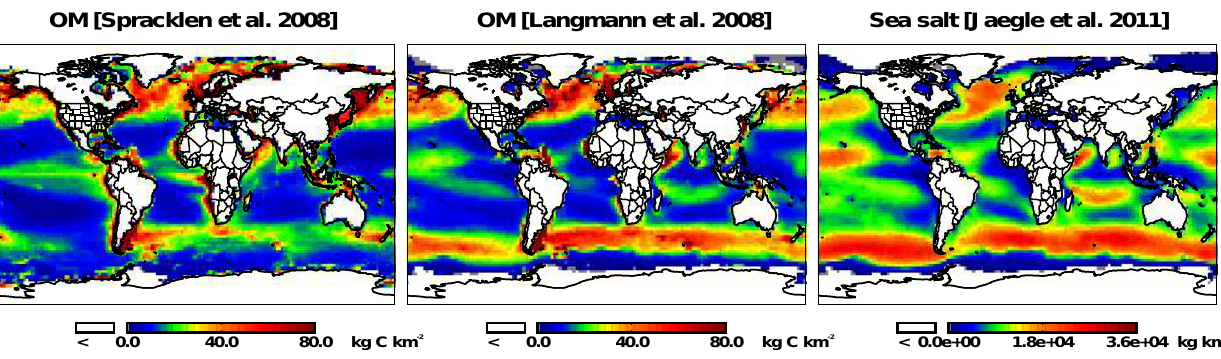
Fig. 1. Global distribution of total annual emissions for 2007 of marine OM by Spracklen et al. (2008) (GC S ) (left), Langmann et al. (2008) (GC L ) (center) and sea salt by Jaegl´e et al. (2011) (right). As discussed in the text, both OM parameterizations are functions of [Chl- a ]. The Langmann et al. (2008) scheme additionally includes dependence on wind speed and SST, as implemented here.